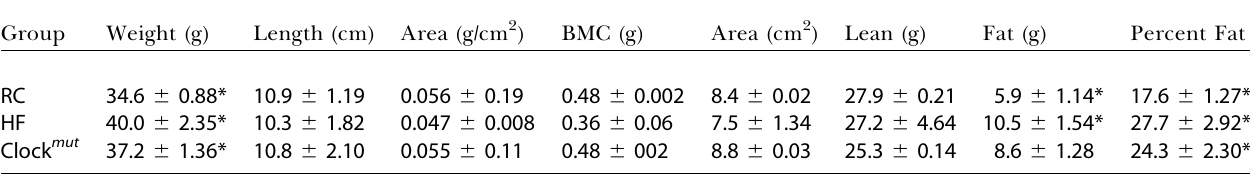
Table 3. Body Mass Index Was Assessed in Mice Feeding on RC and HF